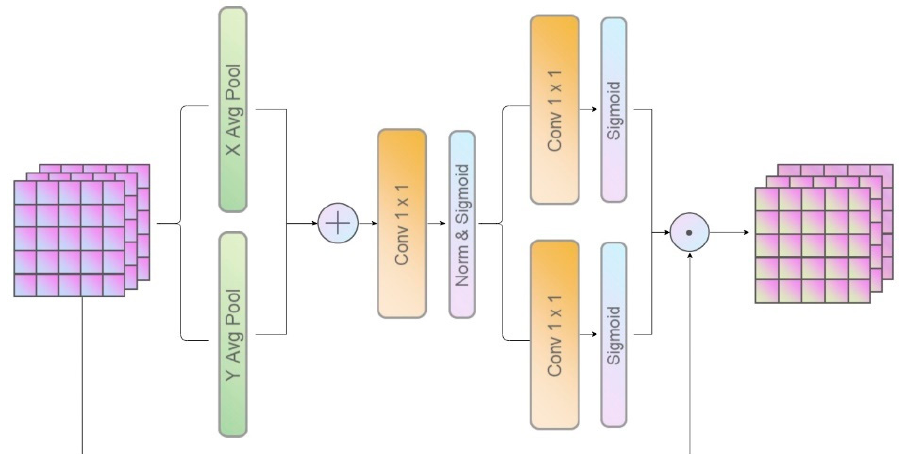
Figure 5. The structure of the coordinate attention block. X Avg Pool and Y Avg Pool denote 1D horizontal global pooling and 1D vertical global pooling, respectively.